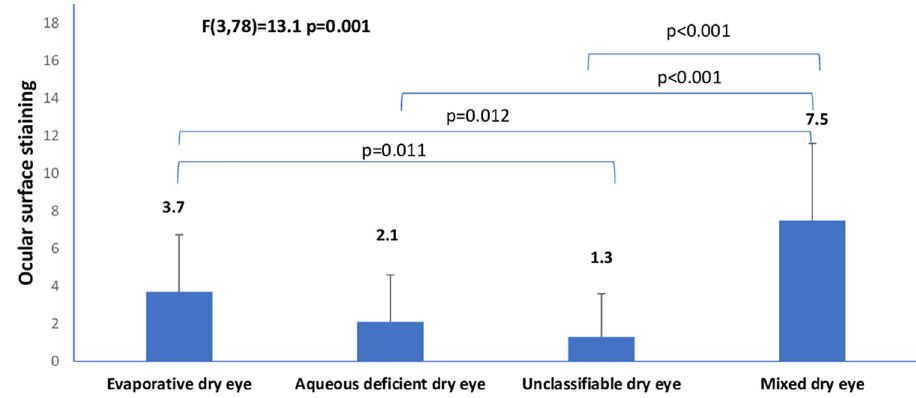
Fig 2. Means of ocular surface staining across clinical subtypes of dry eye.